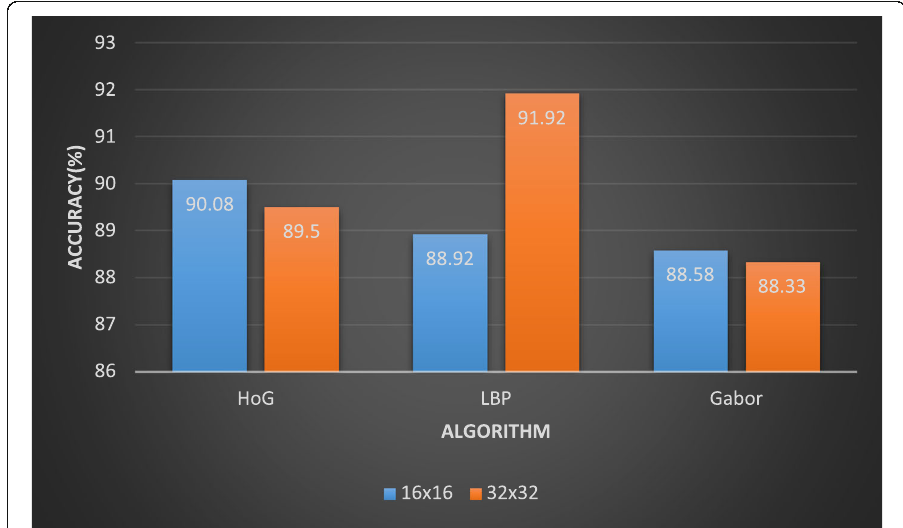
Fig. 6 Performance comparison of person-independent facial expression recognition under different facial patch